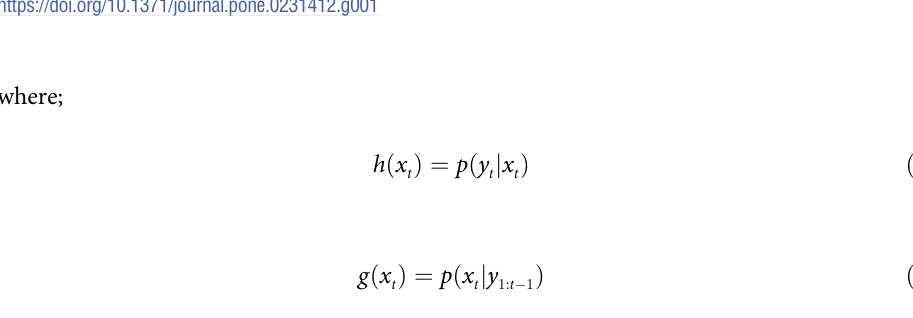
Fig 1. Exact flow of particles for nonlinear filtering—The algorithm steps